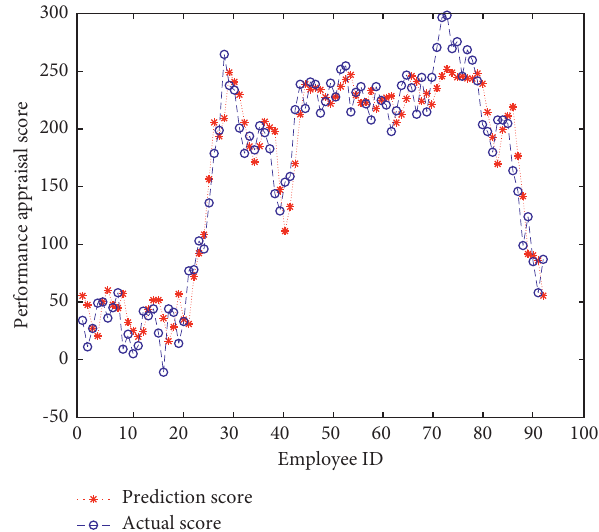
Figure 10: Comparison between fuzzy data mining algorithm prediction and actual